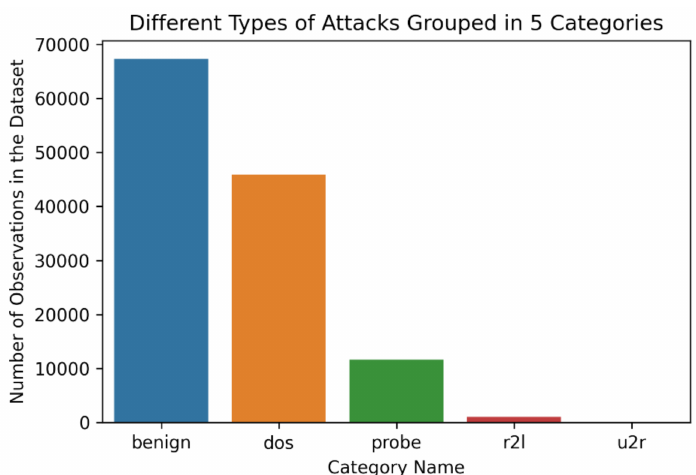
Figure 4. Attack types of NSL-KDD dataset grouped into five different categories